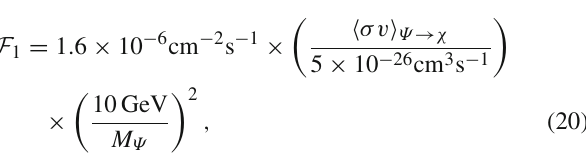
Fig. 20 The inelastic BDM signal under consideration